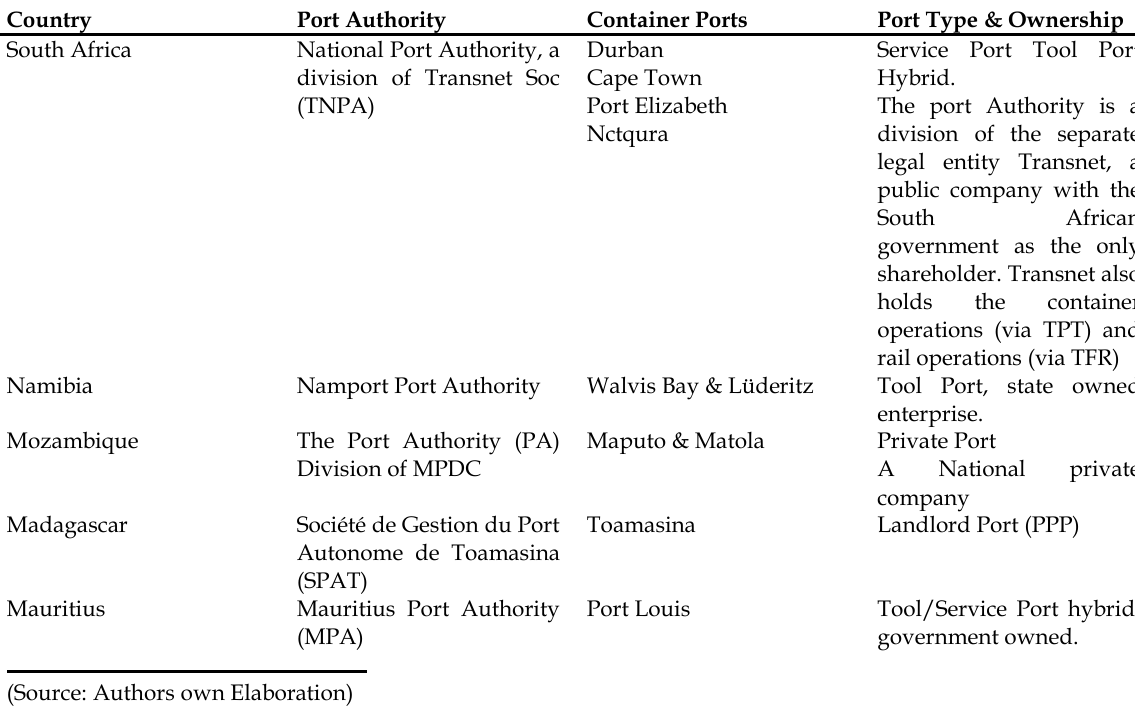
Figure 3. Southern African Ports and Container Operations (Source: Map adapted from www.saplacestours.com , port capacity at 2011) Table 4. Southern African Port Authorities and container